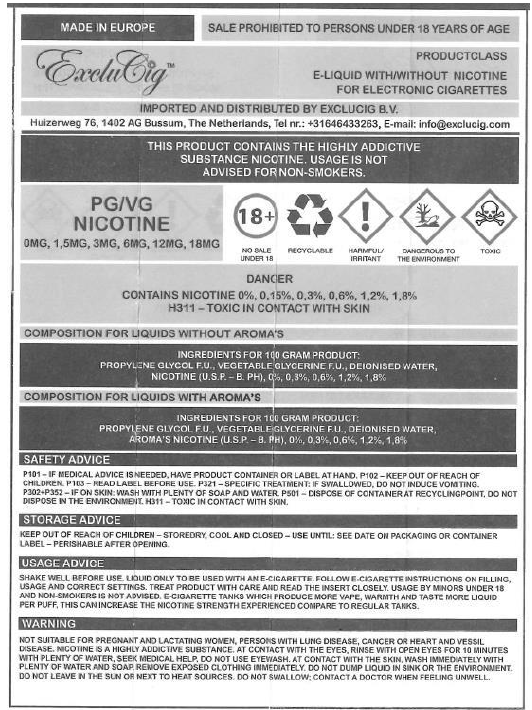
Figure 3. The EU’s new e-cigarette leaflet.